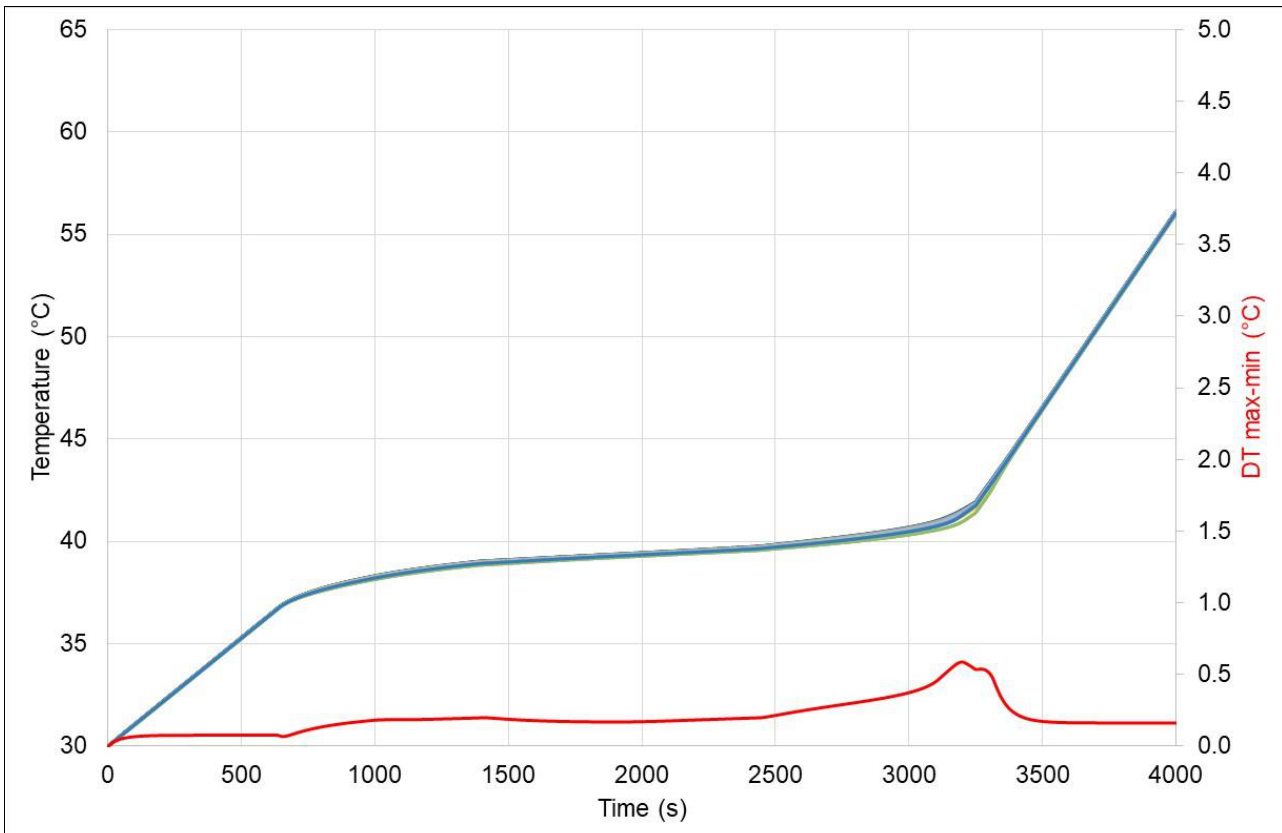
Figure 25. Surface temperature of the cells predicted by the CFD model for a highway driving profile.